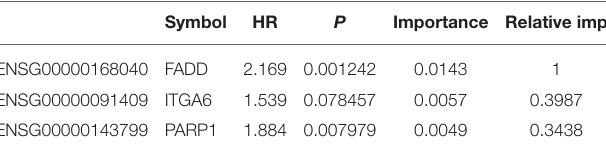
TABLE 1 | Three genes significantly associated with overall survival in the discovery cohort